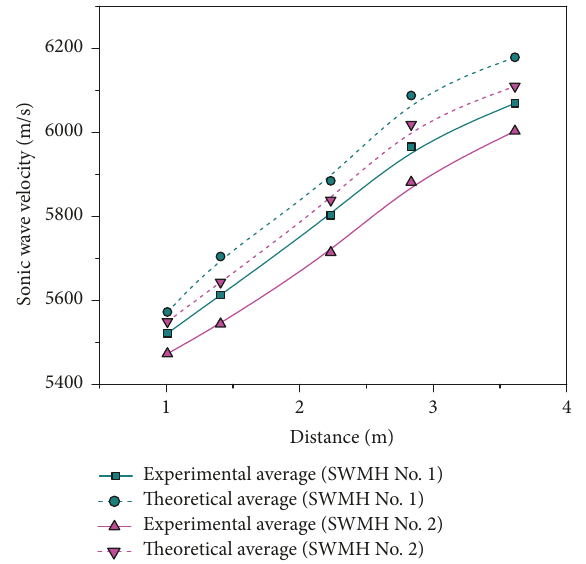
Figure 9: Experimental and theoretical sonic wave velocities versus distance between blasting source and sonic wave monitoring hole.